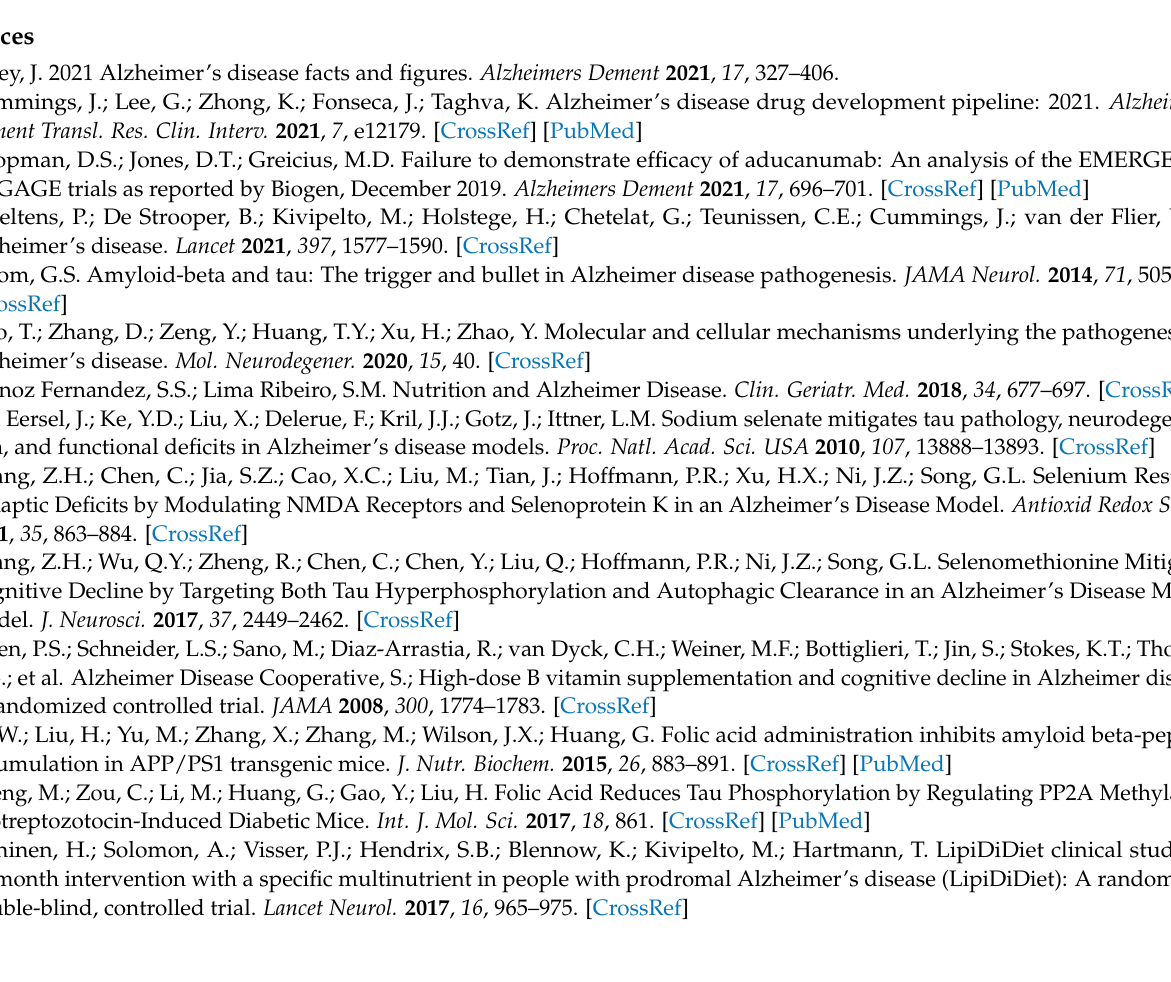
Figure S2–S3: Data of LC–MS untargeted metabolomics analysis; Figure S4: AD pathologies in 2 × Tg-AD